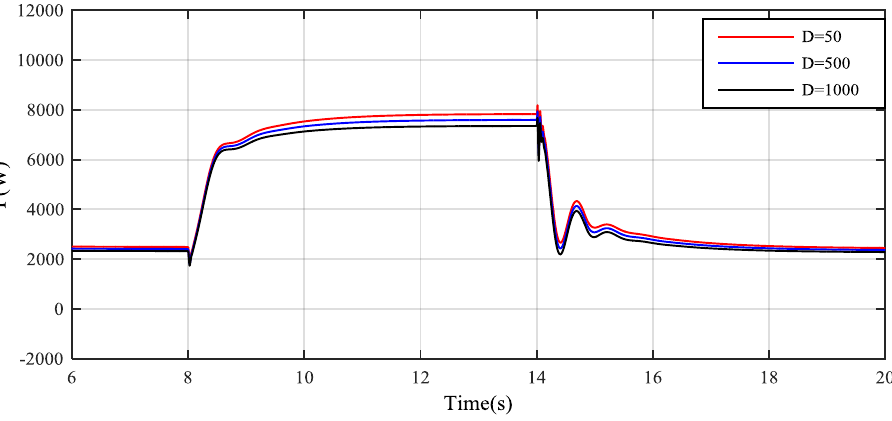
Figure 18. Active power of grid-forming converter with different virtual damping factors.